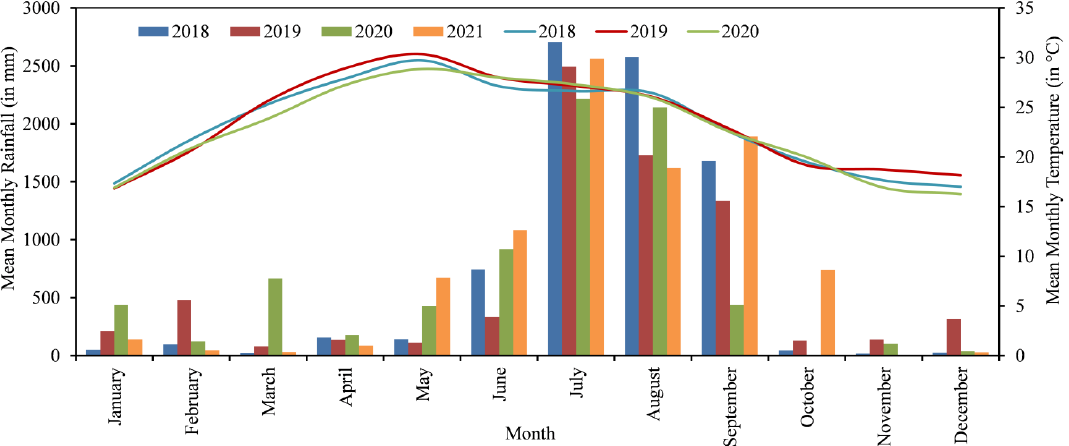
Figure 13. Mean monthly rainfall during years 2018 to 2021 and mean monthly temperature during years 2018 to 2020 for the study site (lines represent temperature and bars represent monthly rainfall data).